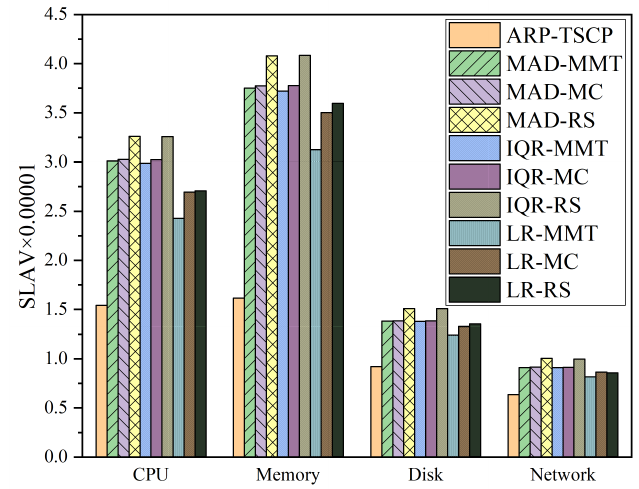
Figure 12. Comparing the SLAV by all methods regarding four resources.